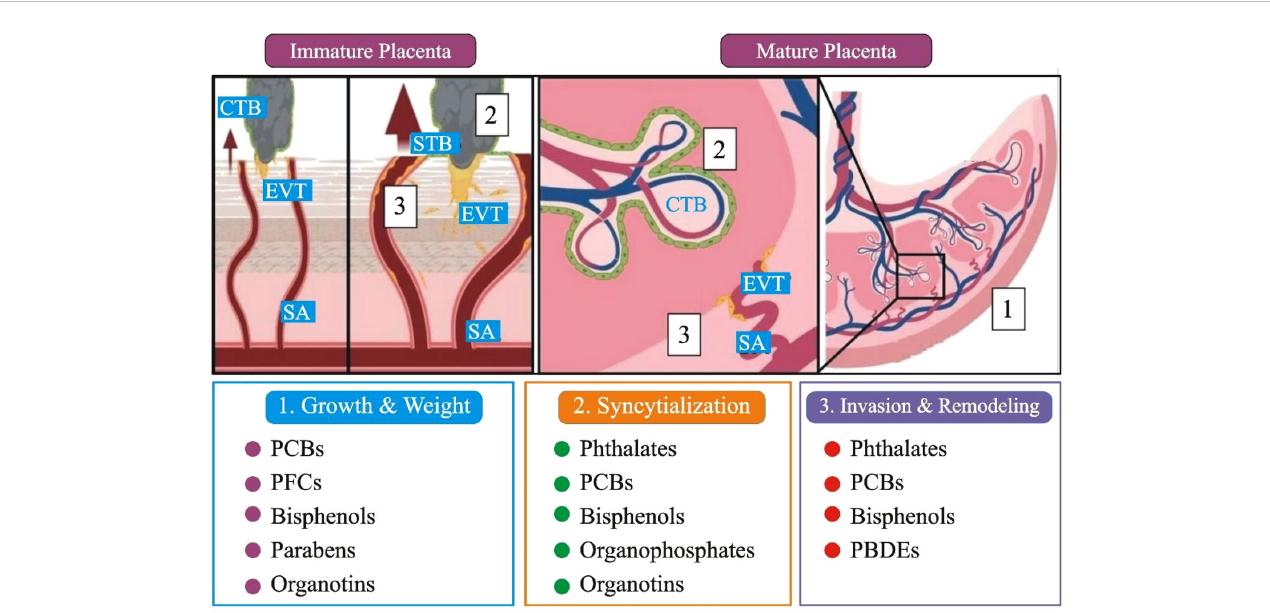
FIGURE 3 A comprehensive summary of the developmental, anatomical, and histopathological sites in the placenta that have been affected by EDCs exposure. (1). Immature placenta (left): cytotrophoblasts (CTB; grey) can differentiate into two separate lineages: invasive extravillous trophoblasts (EVT; yellow) and barrier syncytiotrophoblasts (STBs; green). The arrows represent that EVTs penetrate maternal tissues and, by modi fi cation of the spiral artery (SA), enable enhanced maternal blood fl ow to the placenta. ( 2 ). CTBs restore the STBs population in the mature placenta (right), while SAs that have undergone EVT remodeling fi ll the fetal villi in maternal blood. Placental gross mass/wet weight (grey box 1), CTB fusion/syncytialization (grey box 2), EVT invasion, and SA remodeling (grey box 3) are only a few of the changes caused by EDC; PCBs: polychlorinated biphenyls, PBDEs: polybrominated diphenyl ethers, and PFCs: per fl uorinated compounds (Figure 3 modi fi ed and edited from (79,